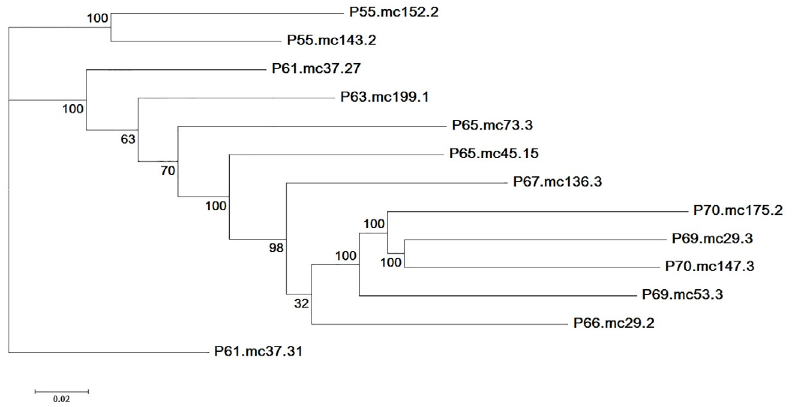
with 0.56% containing 20-plus-copy sequences. These results indicate that F. virguliforme and F. cuneirostrum were more diverged in the uncovered portion rich in duplication and A+T content. For example, we observed C-T/G-A substitutions at a rate of 98% (871/887) in a 10-kb alignment (with 91% identity) of two adjacent contigs in the uncovered portion, where the integrity of both Fv Mont-1 contigs were verified based on their nearly complete and SNP-free coverage at a depth above 100 by reads from each of the other three F. virguliforme isolates. Each contig had a best match (with 90% identity) to the Fc 31157 genome assembly and to the Fp 31156 genome assembly, which were 99.95% identical over the match. Moreover, a maxi- mum likelihood tree of 13 duplicated sequences in the Fv Mont-1 assembly illustrates that the more recently duplicated sequences had a higher A+T content (Fig 1).